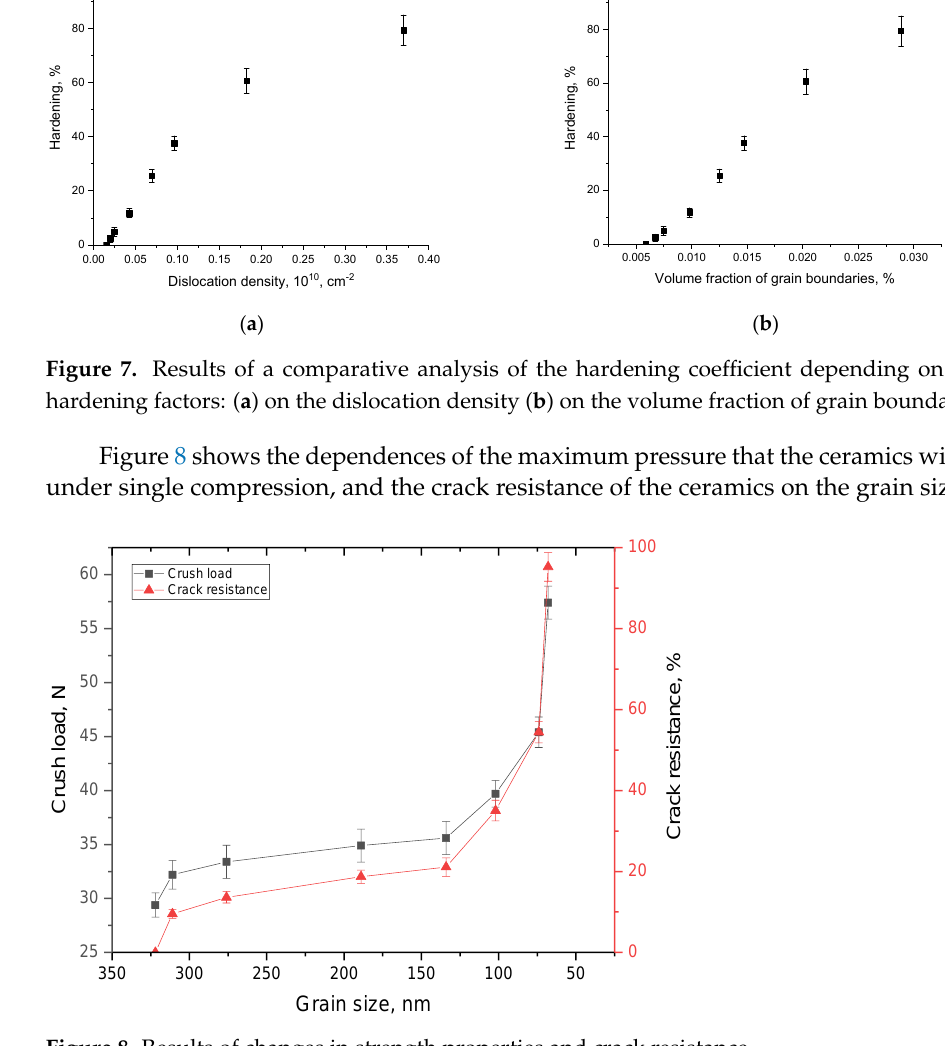
Figure 8. Results of changes in strength properties and crack resistance.